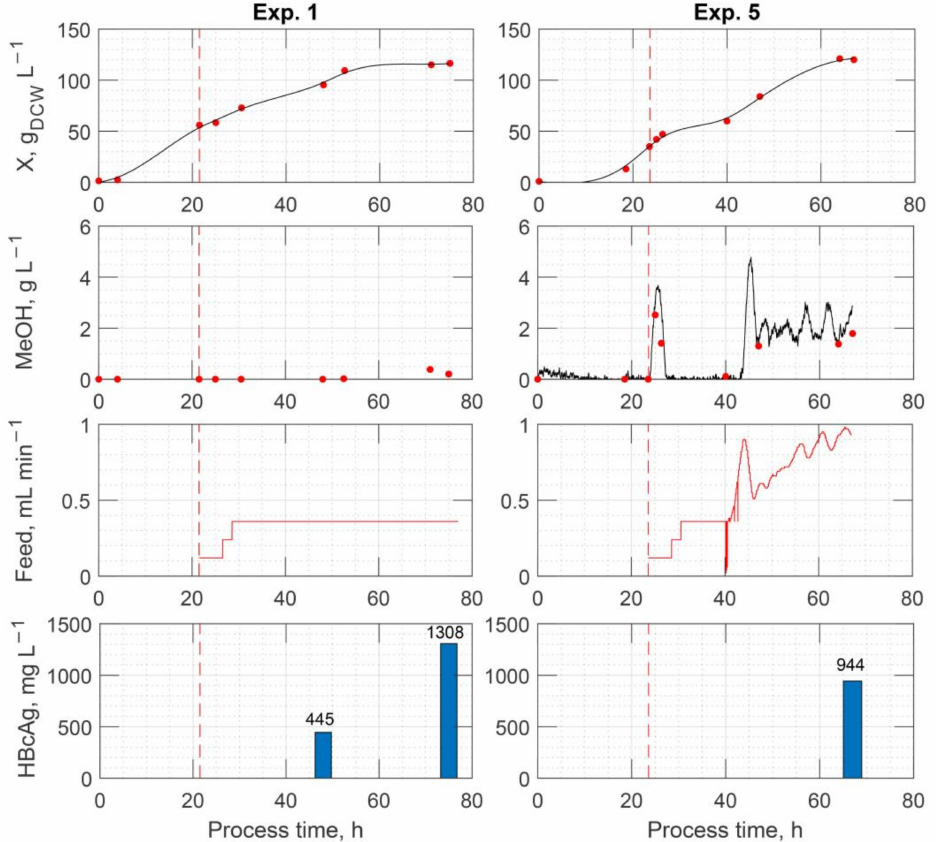
Figure 3. A comparison of two recombinant P. pastoris fermentation processes for HBcAg production employing open-loop and closed-loop (PI) methanol feed profiles. X—dry cell biomass, MeOH— methanol concentration, Feed—substrate feed rate, HBcAg—product concentration. Vertical dashed line indicates the onset of methanol induction phase. A significantly higher process productivity was achieved using a simple open-loop feed profile. Reprinted/adapted with permission from Ref. [19]. 2023, Springer